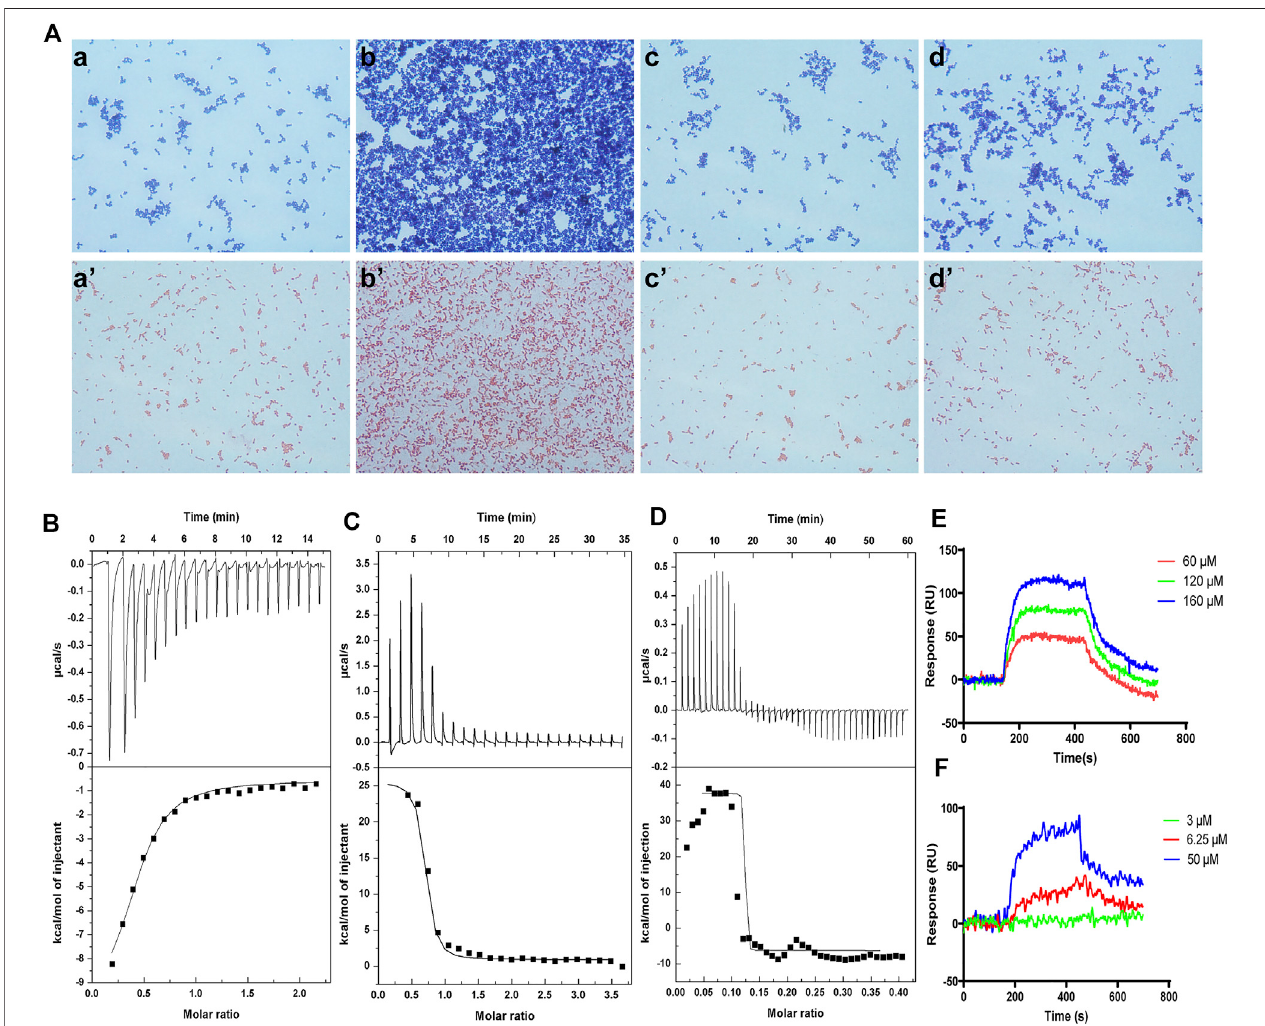
FIGURE 4 | Binding reactions of FM-CATH with LPS and LTA (A) Bacterial agglutination of S. aureus ATCC 25923 (the upper row) and E. coli ATCC 25922 (the lowerrow),respectively.BacteriatreatedwithBSAinTBS(a,a ’ ),FM-CATH(25 μ M)(b,b ’ ),FM-CATH(25 μ M)plusequalvolumeof0.2 mg/ mlLPS(c,c ’ )and0.2 mg/ ml LTA (d, d ’ ) for 30 min before being stained with Gram staining kit. (B), (C), (D) ITC analysis of FM-CATH binding to LPS, polymyxin B binding to LPS, and FM-CATH binding to LTA, respectively. (E), (F) SPRi analysis of LPS and LTA binding to FM-CATH immobilized on a gold chip, respectively.